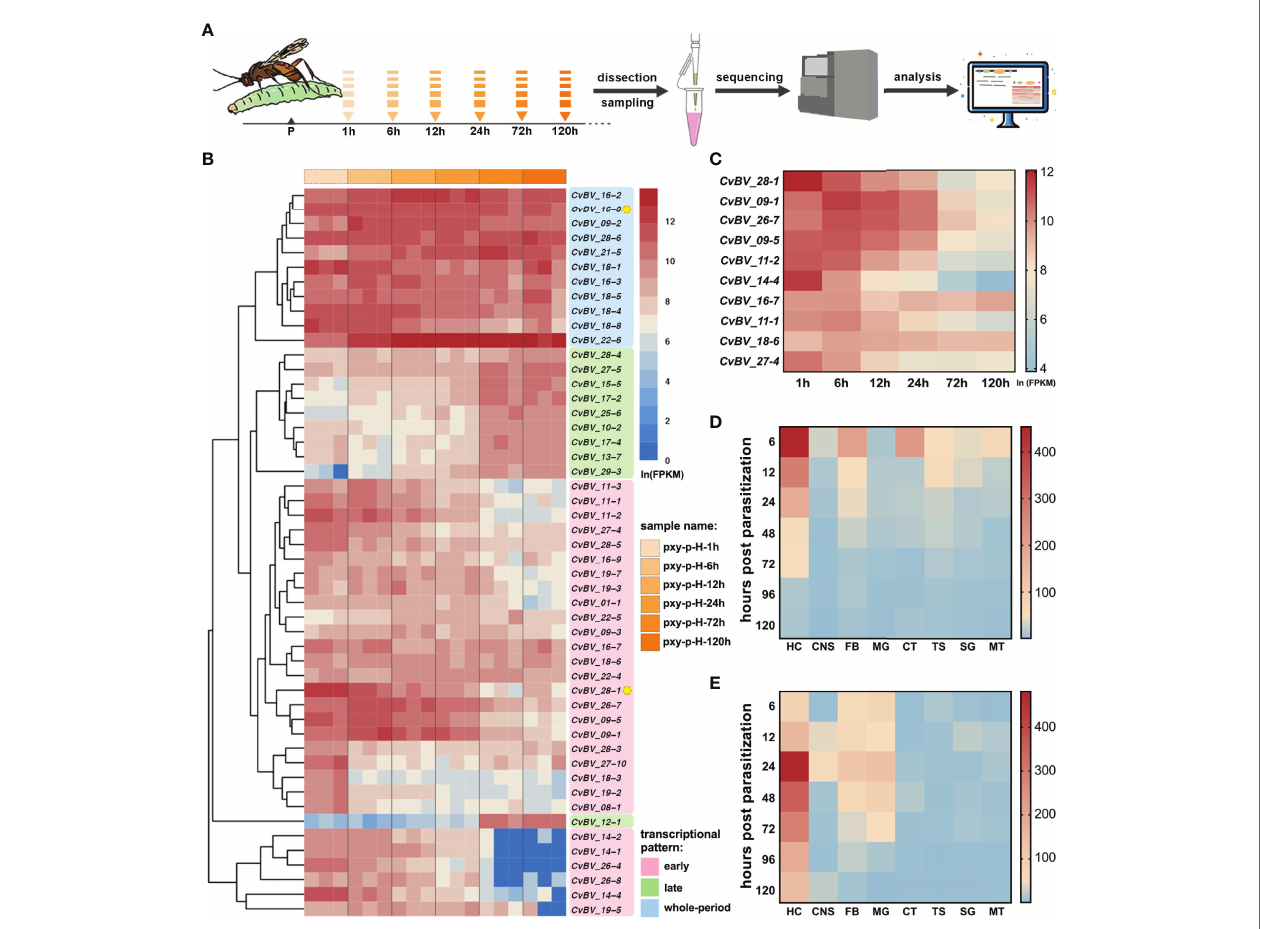
FIGURE 1 | Transcriptional levels of two CTL s in parasitized hosts. (A) Flow chart of the hemocyte transcriptomes of C. vestalis -parasitized P. xylostella at different time points, including 1 h, 6 h, 12 h, 24 h, 72 h and 120 h post-parasitization. (B) Cluster analysis and transcription heatmap of the top 50 CvBV genes in parasitized host hemocytes. The abscissa (x-axis) represents different transcriptomes at 6 time points post-parasitization with three biological replications, and the ordinate (y-axis) represents the top 50 CvBV genes highly expressed in parasitized P. xylostella hemocytes. Values are FPKMs standardized by natural logarithm. Three different transcription patterns are marked with pink, green and blue patches and the relative CvBV gene names. Two CTL genes, CvBV_28-1 and CvBV_16-8 , are marked with yellow circles. (C) Transcription heatmap of the top ten CvBV genes with the early transcriptional pattern in parasitized P. xylostella hemocytes. The abscissa (x-axis) represents different times post-parasitization, and the ordinate (y-axis) represents the top ten CvBV genes with the early transcriptional pattern. Values are the average FPKM standardized by natural logarithm with three biological replications. (D) Transcription heatmap of CvBV_28-1 in 8 tissues of P. xylostella post-infection. The abscissa (x-axis) represents different tissues including hemocytes (HC), central neural system (CNS), fat body (FB), midgut (MG), cuticular (CT), testis (TS), silk gland (SG) and Malpighian tubule (MT), and the ordinate (y-axis) represents different time points post-parasitization. Values are the average of relative transcriptional level with three biological replications. (E) Transcription heatmap of CvBV_16-8 in 8 tissues of P. xylostella post-infection. The abscissa (x-axis) represents different tissues, including HC, CNS, FB, MG, CT, TS, SG and MT, and the ordinate (y-axis) represents different time points post-parasitization. Values are the average of relative transcriptional level with three biological